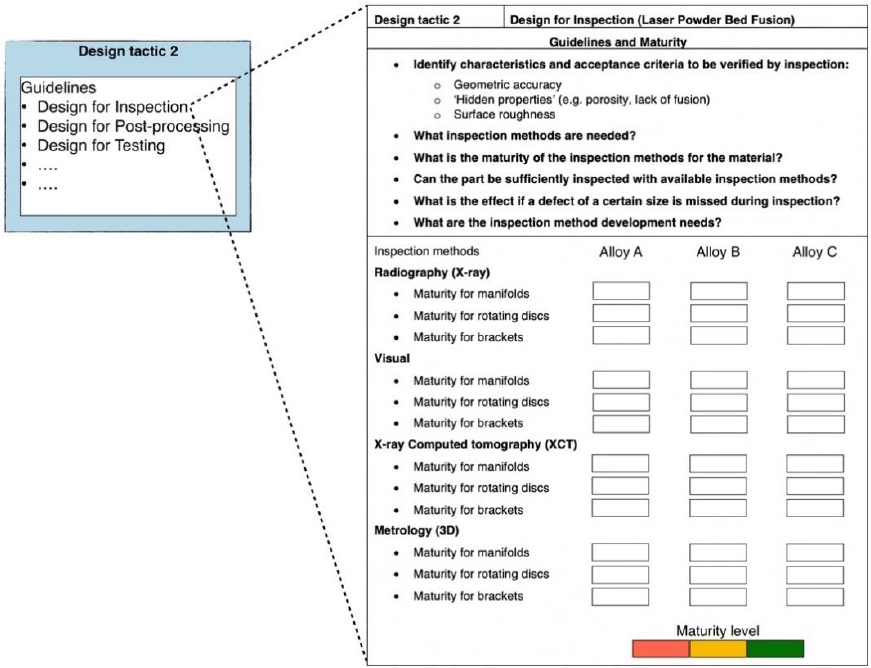
Figure 9. Example of guidelines to be defined for each design tactic. In this case, tactic 2 ‘Design for Qualification by considering the product in the AM process chain’ is shown.